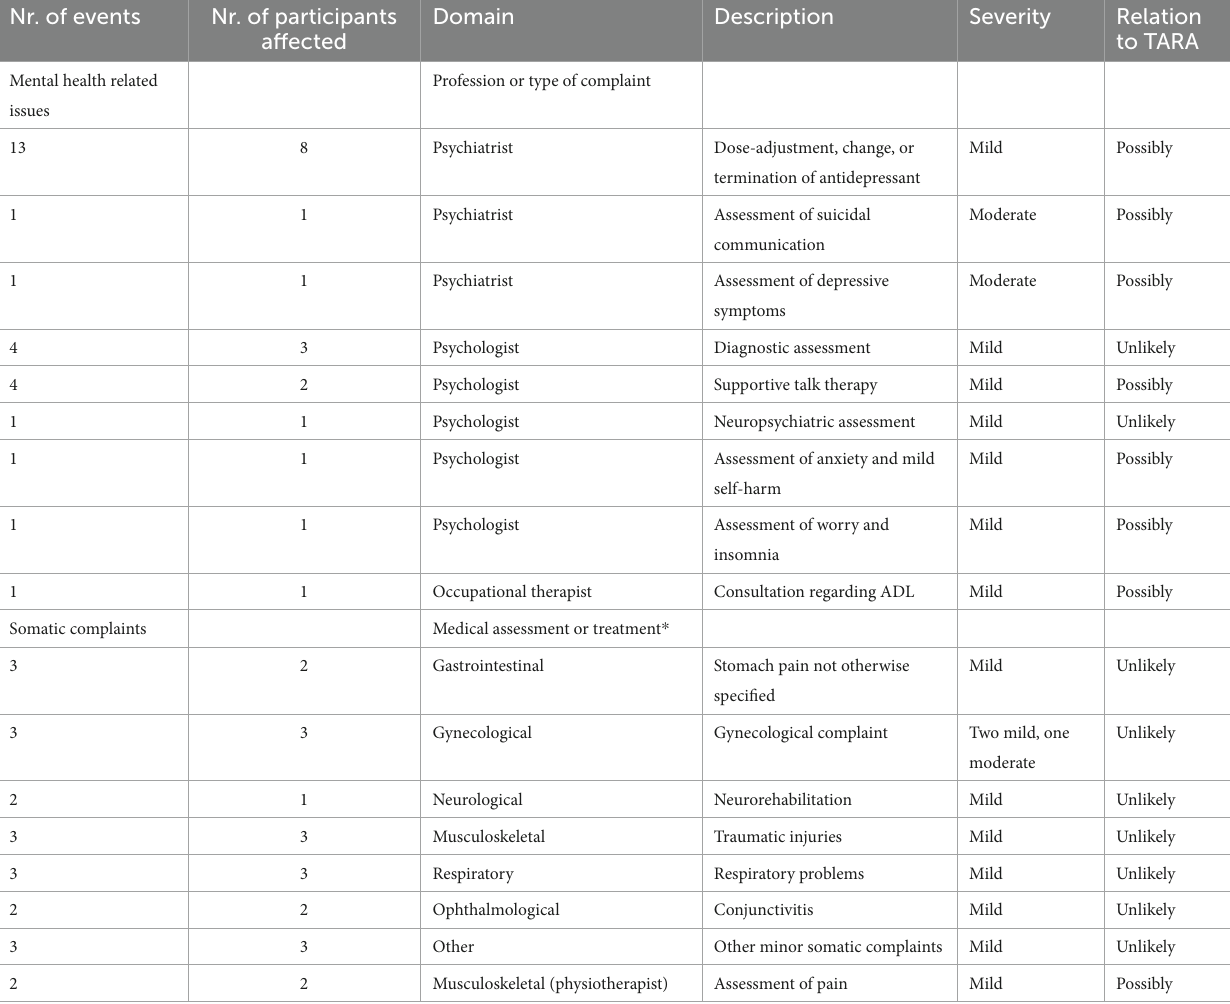
TABLE 3 Summary of Adverse Events Between T0 and T1, Intention-To-Treat Population. Nr. of